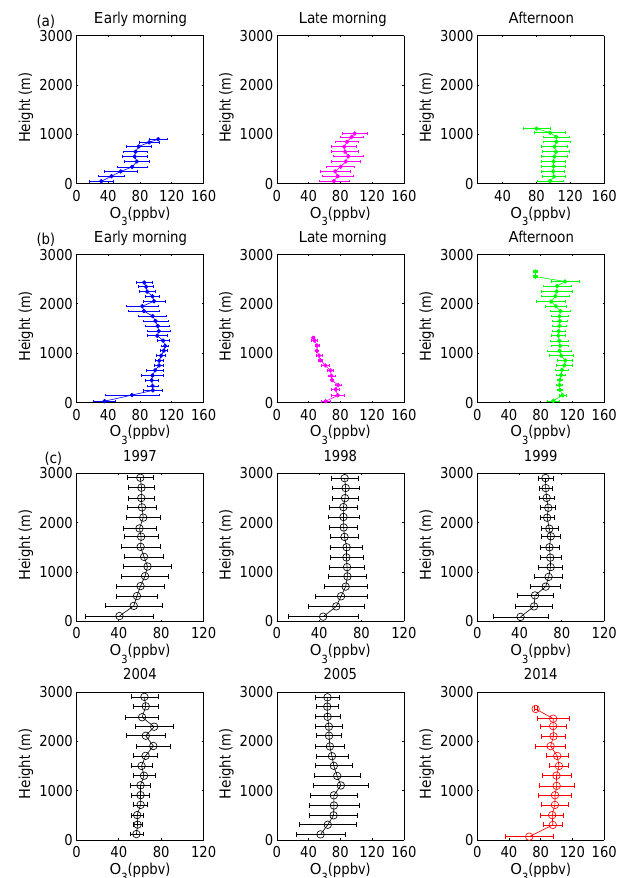
Figure 8. Comparison of average O 3 vertical profiles observed in the lower troposphere during summer of different years. (a) shows O 3 vertical profiles from the tethered balloon experiments during summer of 2014 averaged over early morning (05:00–08:00LT), late morning (08:00–12:00LT), and afternoon (12:00–19:00LT). Panel (b) presents O 3 vertical profiles from the UAV experiments during summer of 2014 averaged over early morning (flights 3, 4, and 5), late morning (flight 1), and afternoon (flights 2, 6, and 7). Panel (c) shows O 3 vertical profiles averaged over daytime (05:00– 19:00LT) MOZAIC measurements in summer of 1997, 1998, 1999, 2004, 2005, and our Raoyang measurement in summer of 2014. The error bars indicate 1 standard error of the